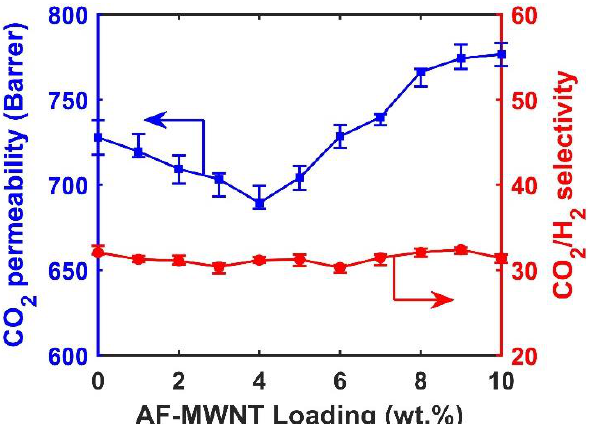
Figure 6. Effects of AF-MWNT loading on CO 2 permeability and CO 2 /H 2 selectivity under 1.5-MPa Figure 6. E ff ects of AF-MWNT loading on CO 2 permeability and CO 2 / H 2 selectivity under 1.5-MPa feed pressure: CO 2 permeability (  ) and CO 2 /H 2 selectivity (●). Error bars represent the minimum and feed pressure: CO 2 permeability ( (cid:4) ) and CO 2 / H 2 selectivity ( • ). Error bars represent the minimum and maximum values of three samples. maximum values of three samples.